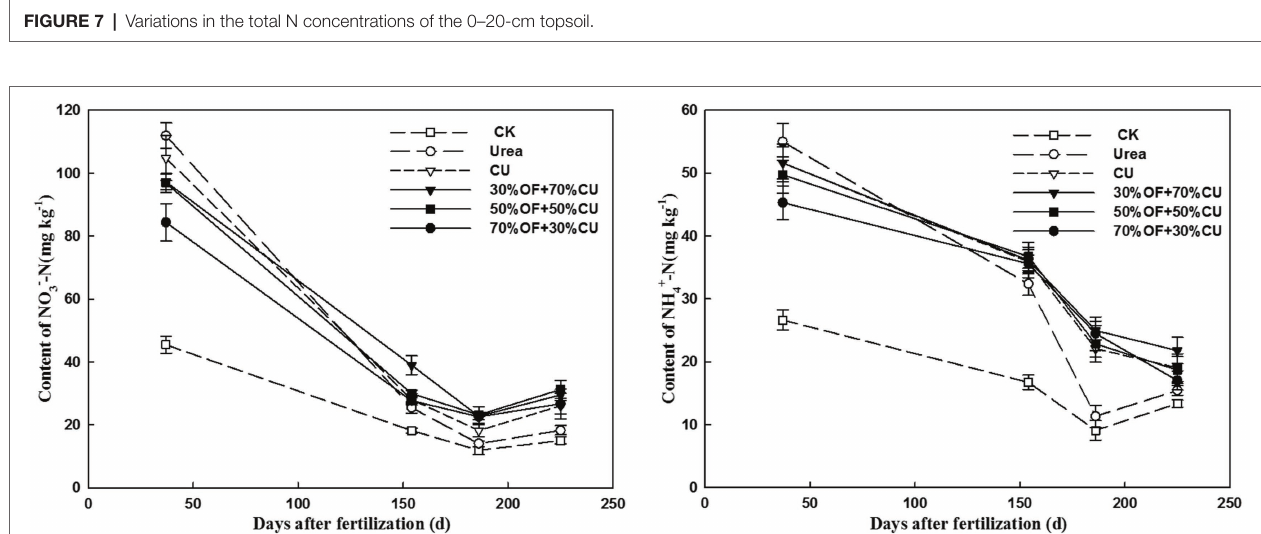
FIGURE 7 | Variations in the total N concentrations of the 0–20-cm topsoil.